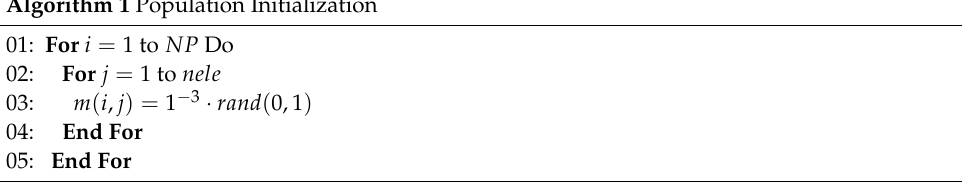
Algorithm 1 Population